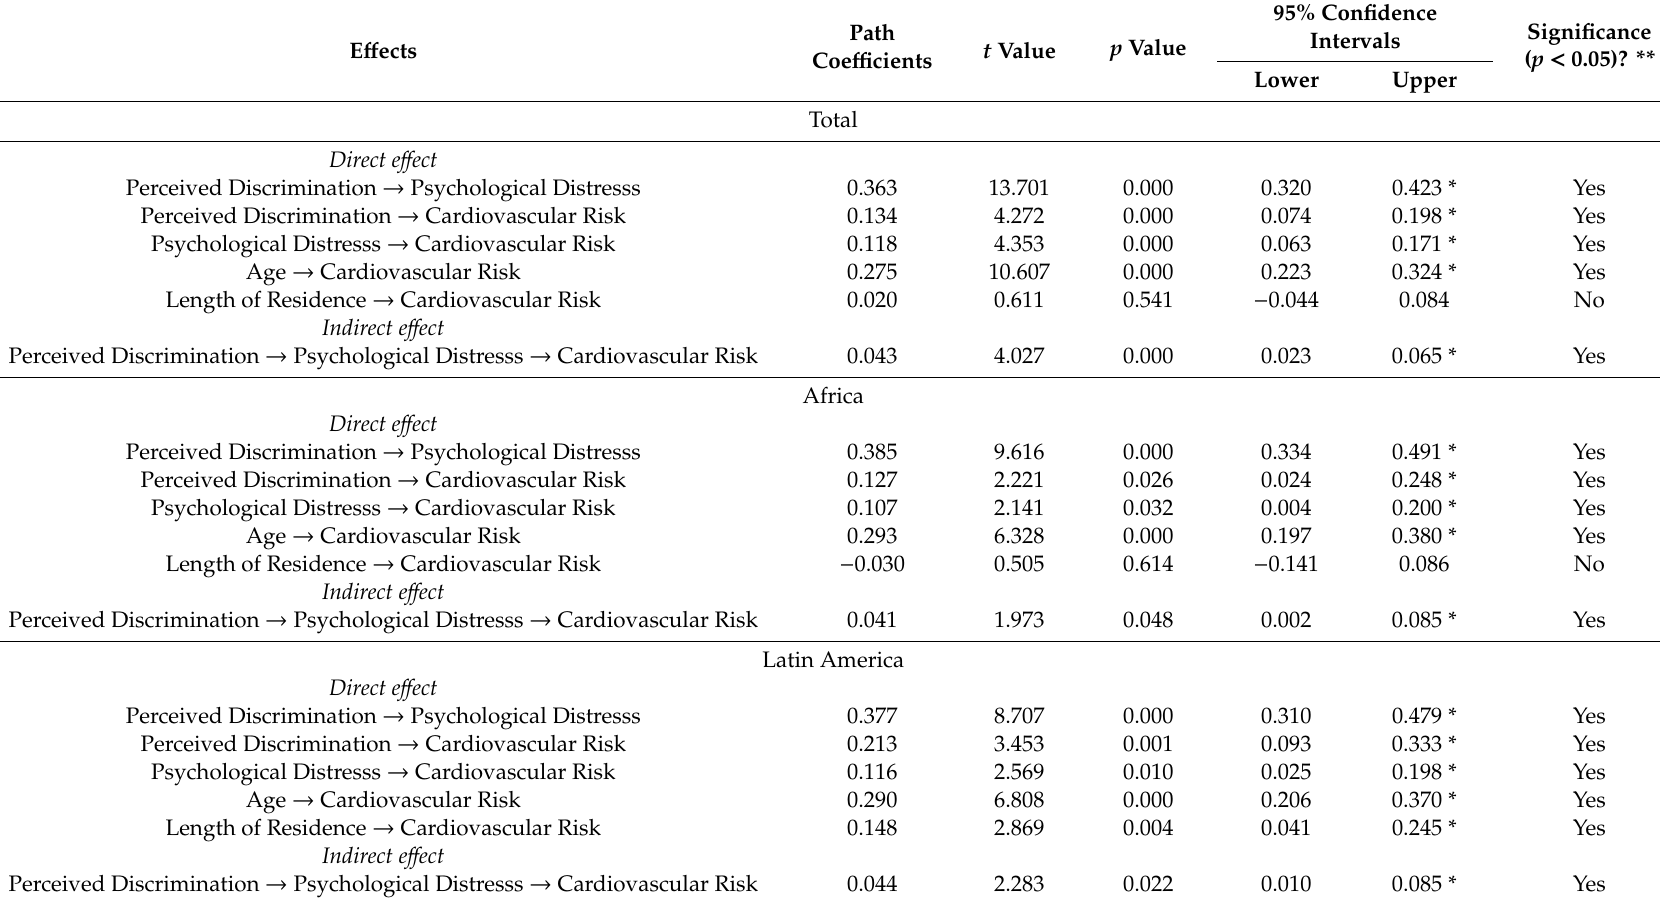
Table 3. Path model coe ffi cients for the total group of immigrants, based on geographic origin and gender.